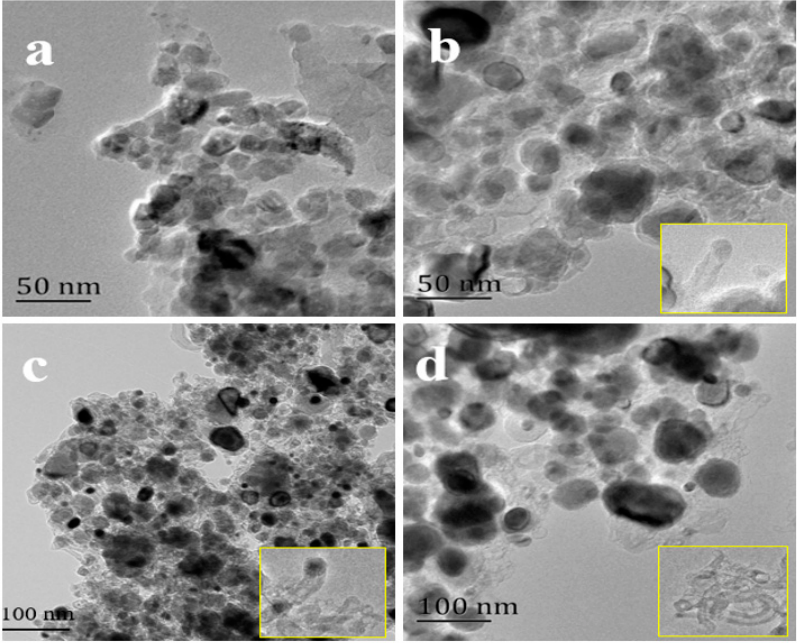
Figure 4. TEM images of: ( a ) FeCo/NC-400; ( b ) FeCo/NC-500; ( c ) FeCo/NC-600; and ( d ) FeCo/NC-700.